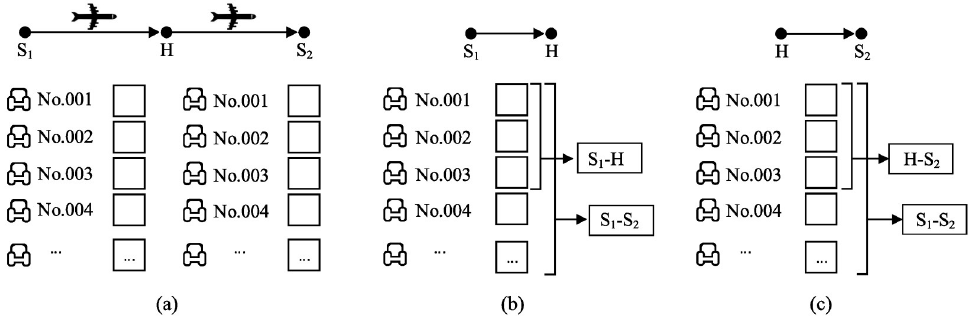
Fig 3. Virtual nesting control in the airline